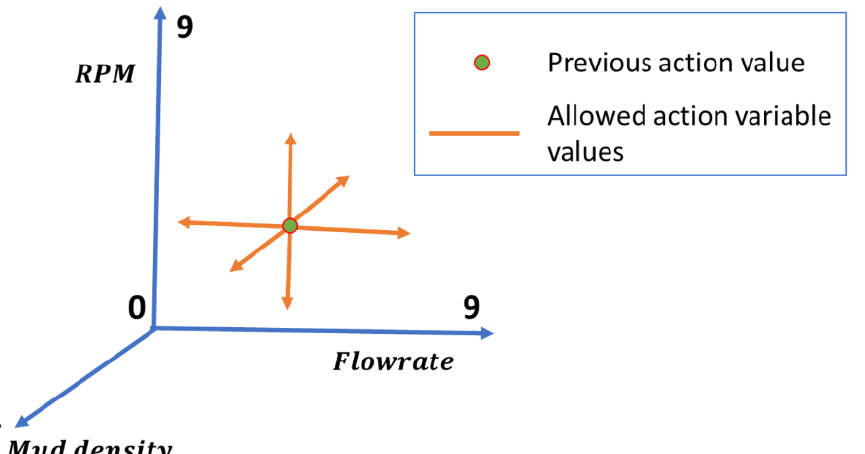
Figure 10. Method for estimating the action set associated with sequential metric. Numbers on axes are in control variable value units.